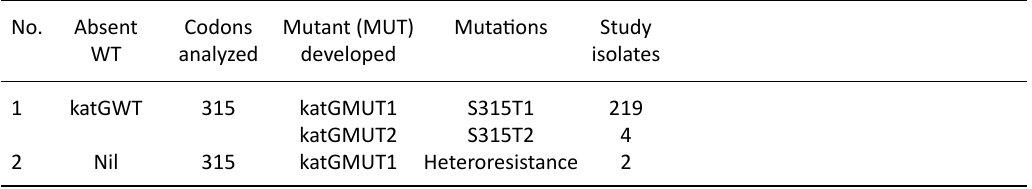
Table 3. Mutations detected by GenoType MTBDR plus assay in inhA promoter region consistent with low level isoniazid resistant Mycobacterium tuberculosis